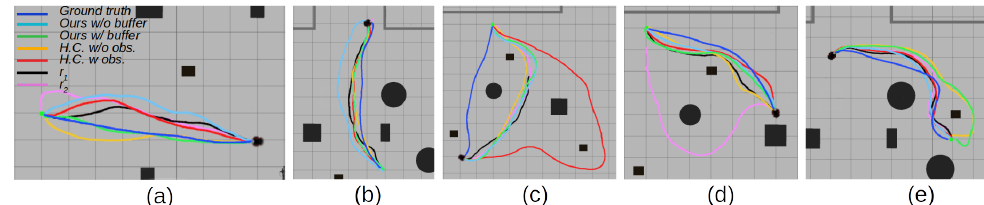
Figure 4. Examples of experimental results in a simulated environment with policy trajectory comparison to the recorded ground truth. The ground truth trajectories were used as samples in the proposed neural network training. ( a ) An example with no obstacles between the robot and a goal. ( b ) An example with a compromised start location. ( c , d ) Examples with obstacles between the robot and the goal. ( e ) An example where the learned policy does not follow the expert trajectory, but still exhibits the expert feature properties. Table 5. Experiments in simulated